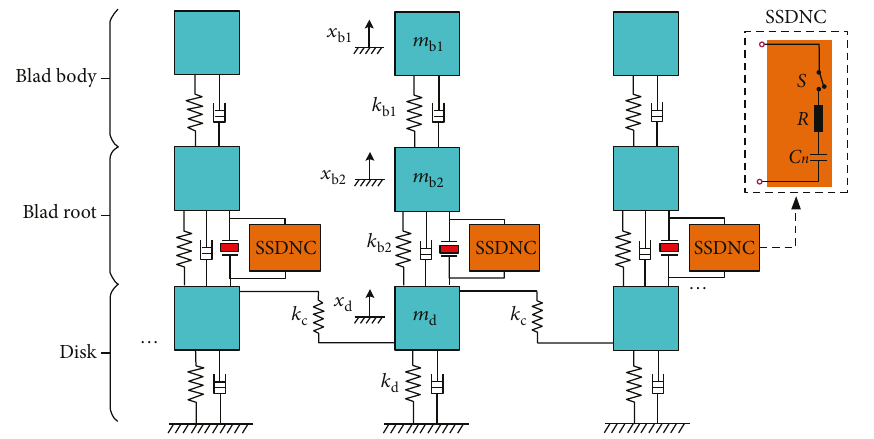
Figure 2: Lumped parameter model of the blisk with SSDNC.